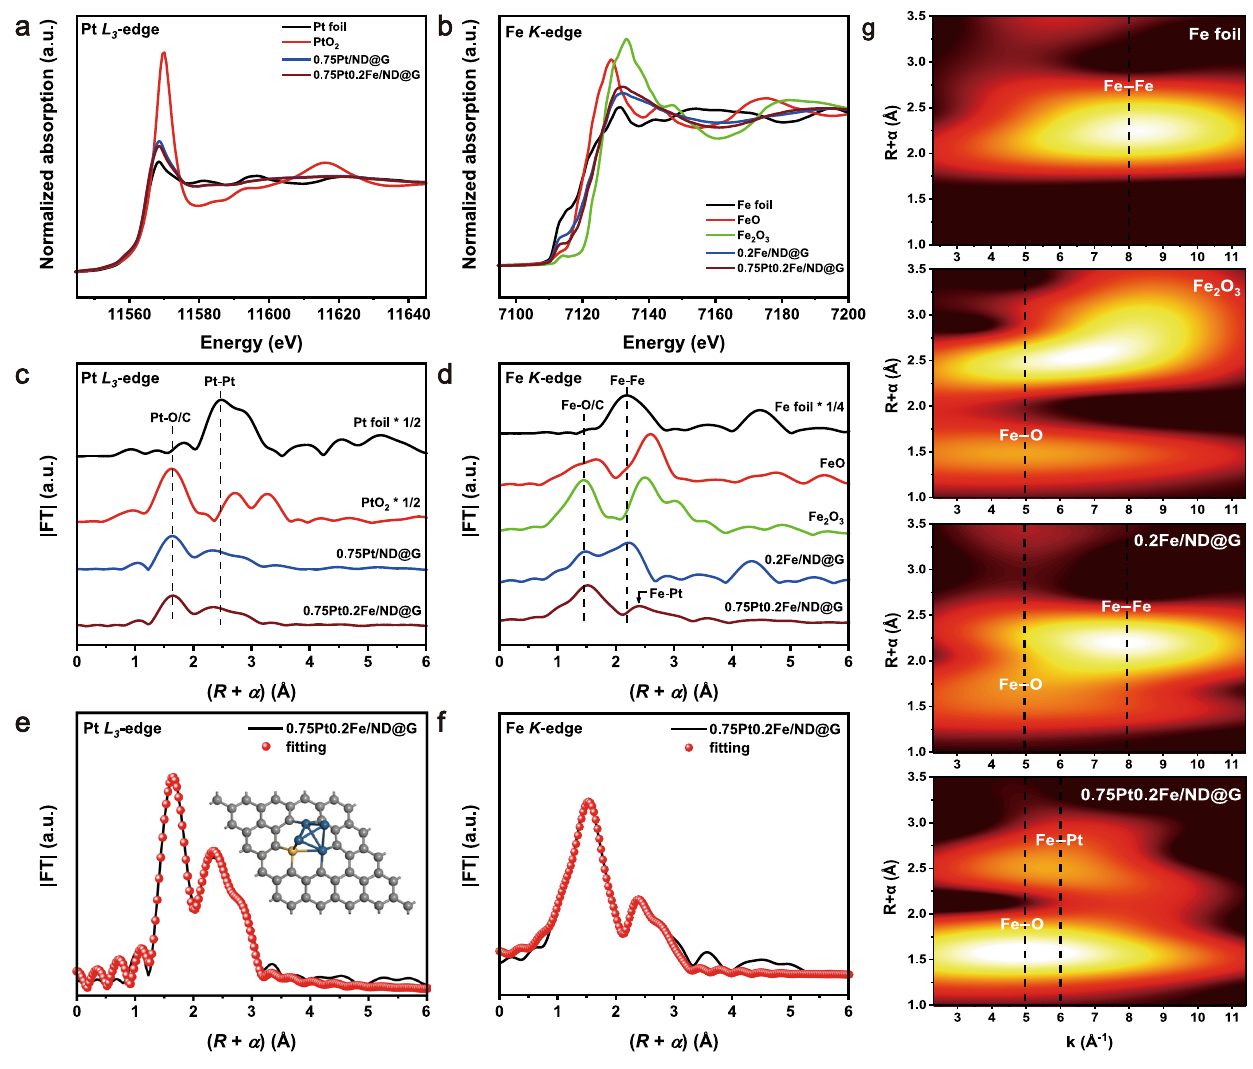
Fig. 2 | Synchrotron XAFS measurements of catalysts. a XANES and c FT-EXAFS spectra at the Pt L 3 -edge (without phase correction) of the 0.75Pt/ND@G and 0.75Pt0.2Fe/ND@G; b XANESspectraand d FT-EXAFSattheFe K -edgeofthe0.2Fe/